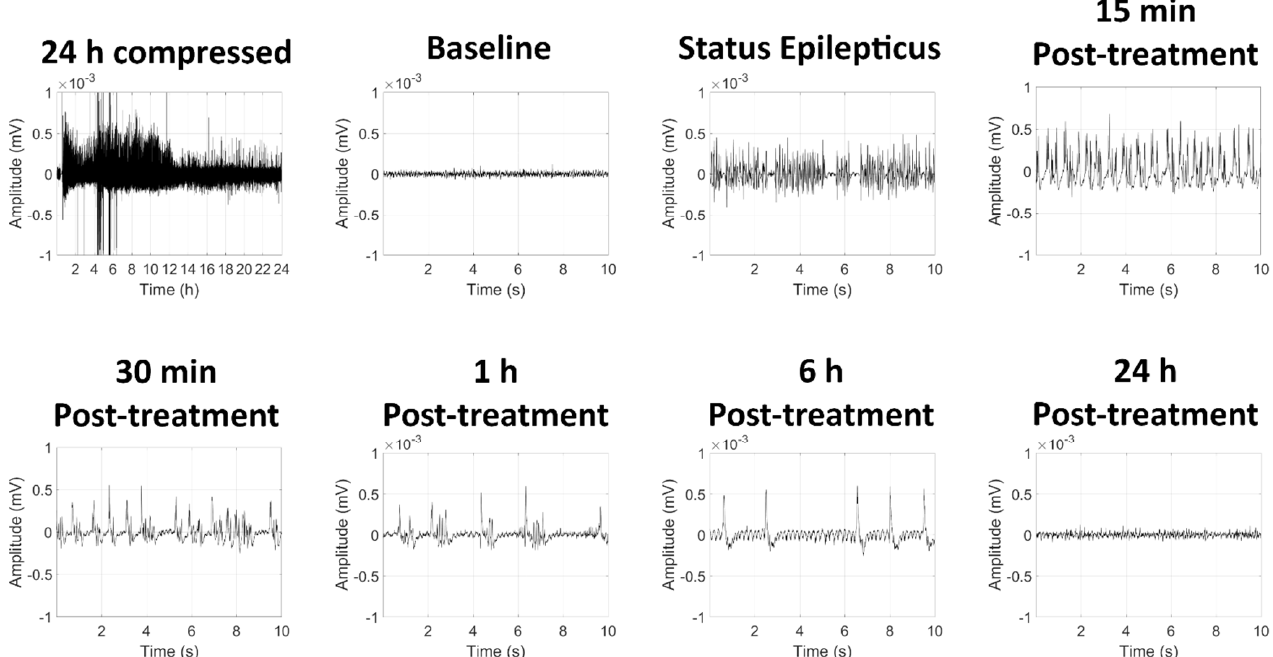
Figure 1. Effects of soman-induced status epilepticus and delayed midazolam treatment on electroencephalographic (EEG) activity in KIKO mice. Representative images are shown of 24 h compressed signal and 10-sec recordings at baseline (24 h prior to soman exposure), status epilepticus, as well as 15 min, 30 min, 1 h, 6 h, and 24 h after midazolam (3 mg/kg; SC) treatment.